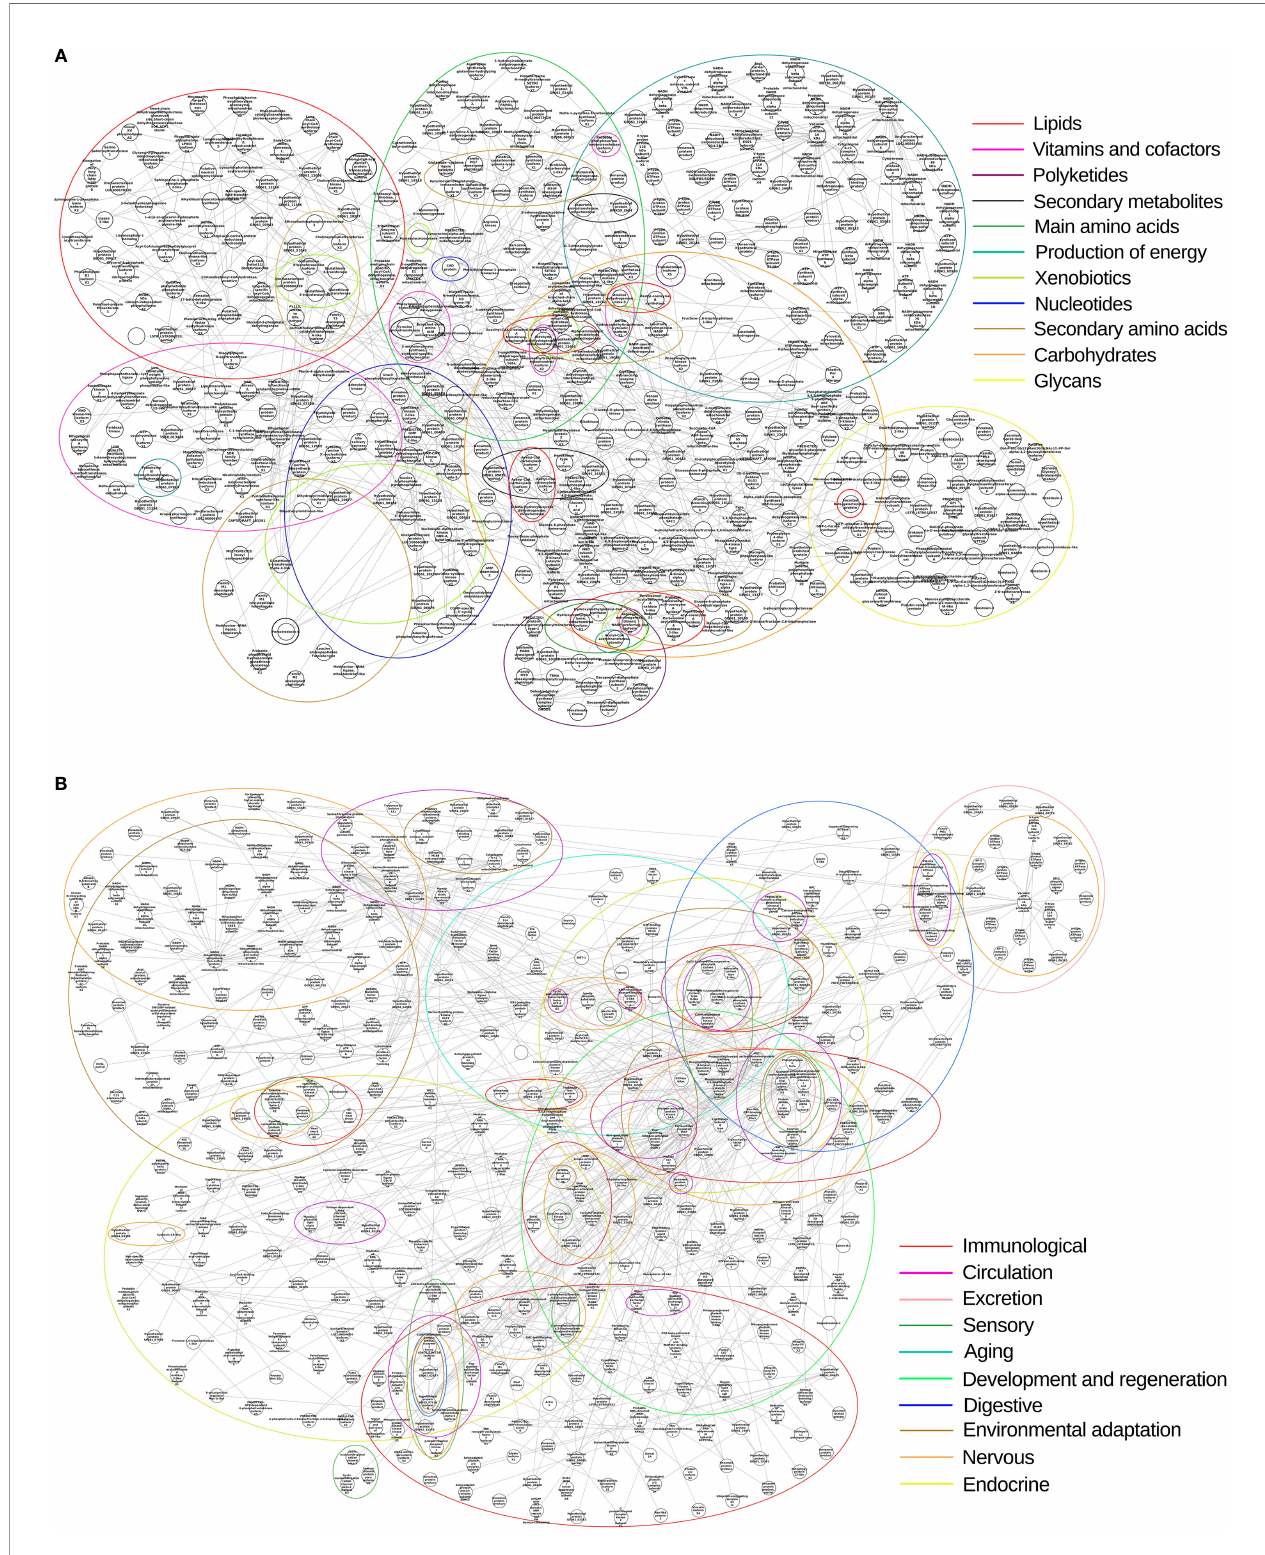
FIGURE 12 | Biological network of R. neglectus . (A) Biological network of biosynthesis and intratissue metabolism pathways. (B) Biological network of systemic component pathways. Identi fi ed homologous component clusters with degree > 0. Unmatched transcripts are represented in unnamed